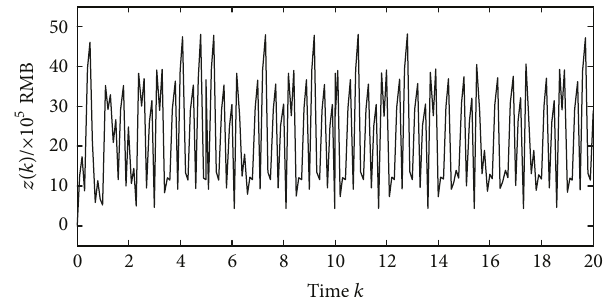
Figure 7: Evolution process of total cost under the robust 𝐻 ∞ control strategy.